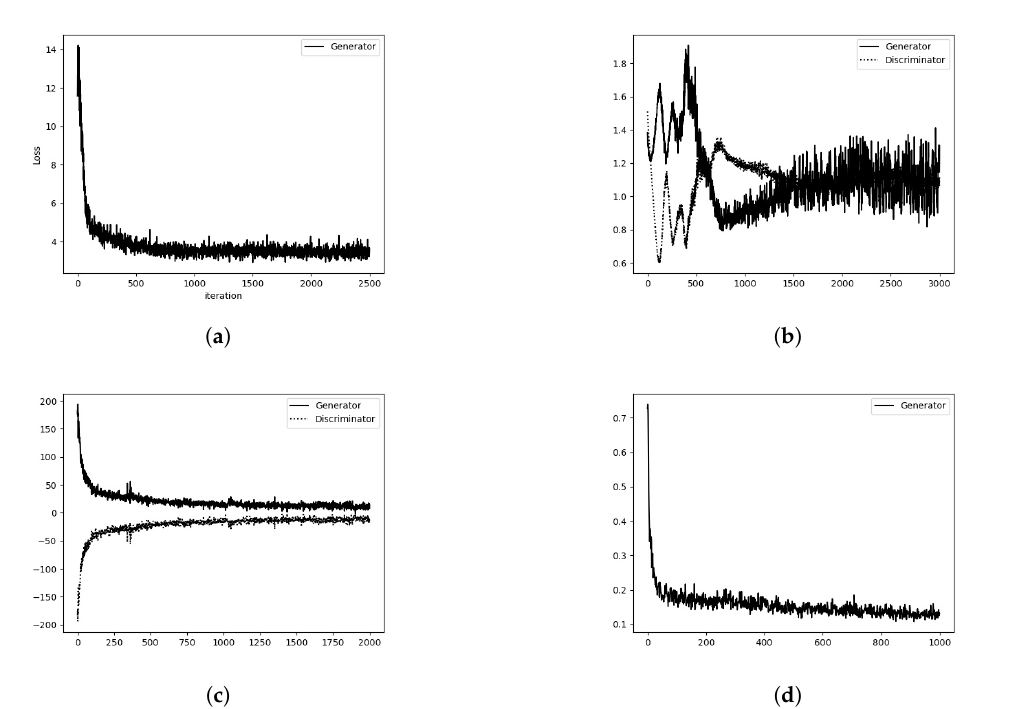
Figure A1. Generators losses. Dotted lines represent discriminator losses; full lines represent generator losses. For CEGEN and SIGGAN there is no discriminator neural network. ( a ) CEGEN. ( b ) TSGAN. ( c ) COTGAN. ( d ) SIGGAN.